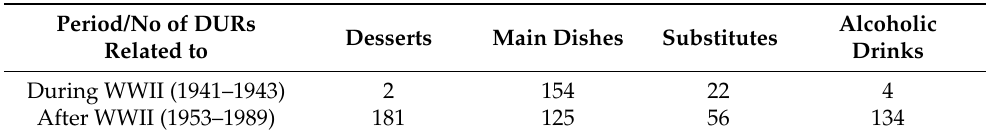
Alcoholic Drinks